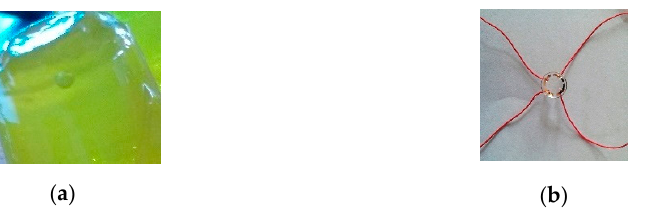
Figure 4. Picture of one of the phantoms representing a healthy eye ( a ) and the associated lens ( b ). Experimental conditions (temperature, baking and moulding) have made it possible to preserve eight healthy eye phantoms (S1 to S8) and eight eye phantoms presenting glaucoma (G1 to G8). These populations were randomly separated into two subpopula- tions, one for model creation and the other for validation.